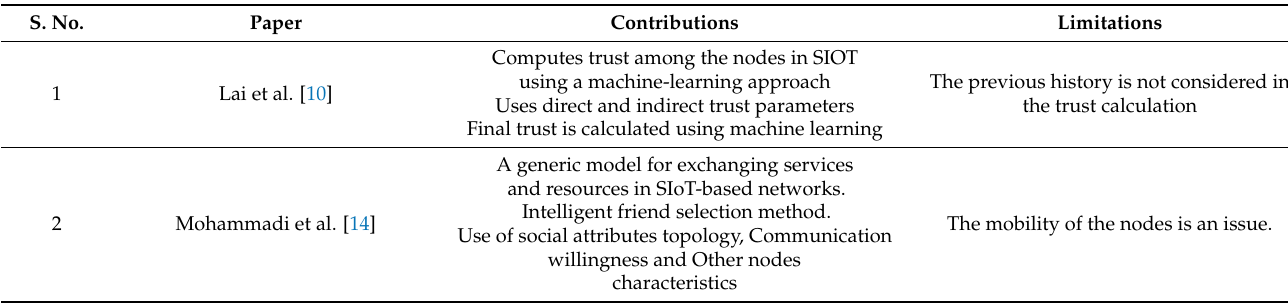
Table 1. Relevant